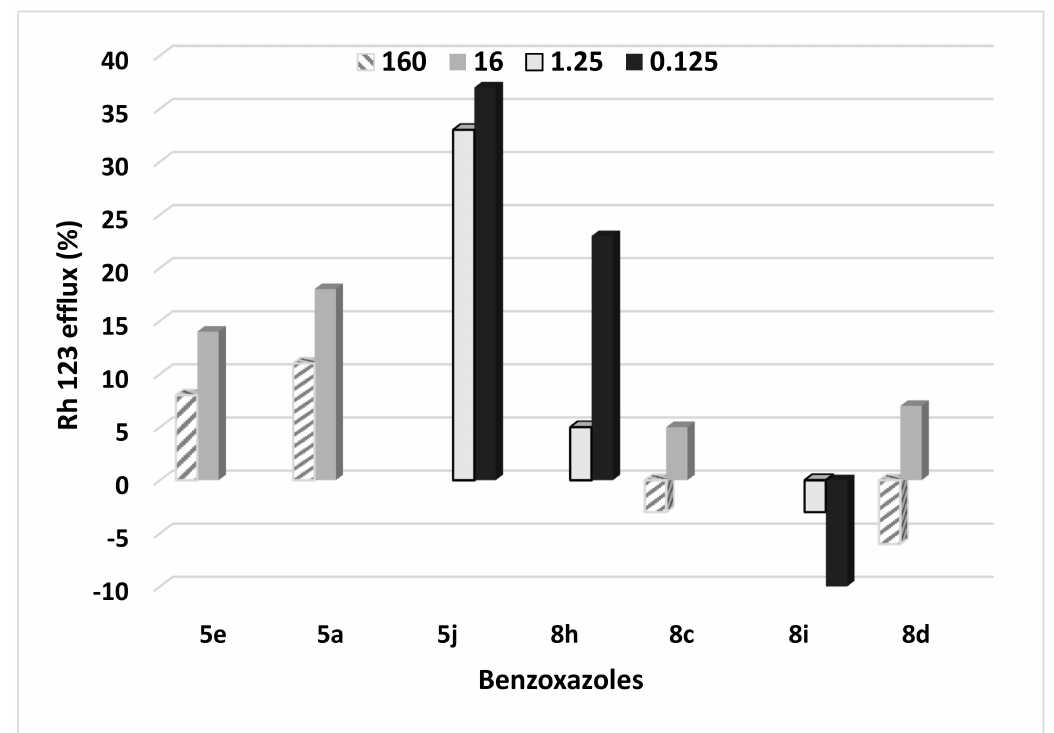
Figure 2. Benzoxazoles’ influence on the passive efflux of Rho123. Legend: Rhodamine (Rho123) content as a relative difference between the control and test (%) in the post-culture medium of the C. albicans SC5314 treated with compounds 5a , 5e , 5j , 8c , 8h , 8i and 13d at different concentrations. %C = (A(test) − A(control))/A(control) × 100, where A (control) = 3901. The C. albicans cells were incubated with Rho123 at 20 mM for 10 min and the Rho123 extracellular conc. was determined against a standard curve following the cell lysis with Triton 6100. Standard curve: A = 1155.9 C + 3901 → C = A − 3901 Data mean the average of three separate repeats